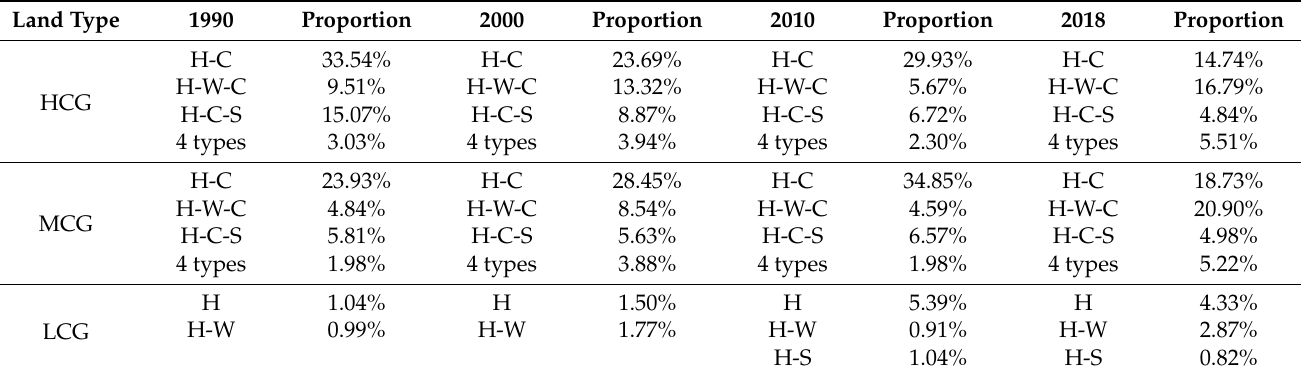
Table 4. Types and proportions of main service hotspots in grassland with different coverage during